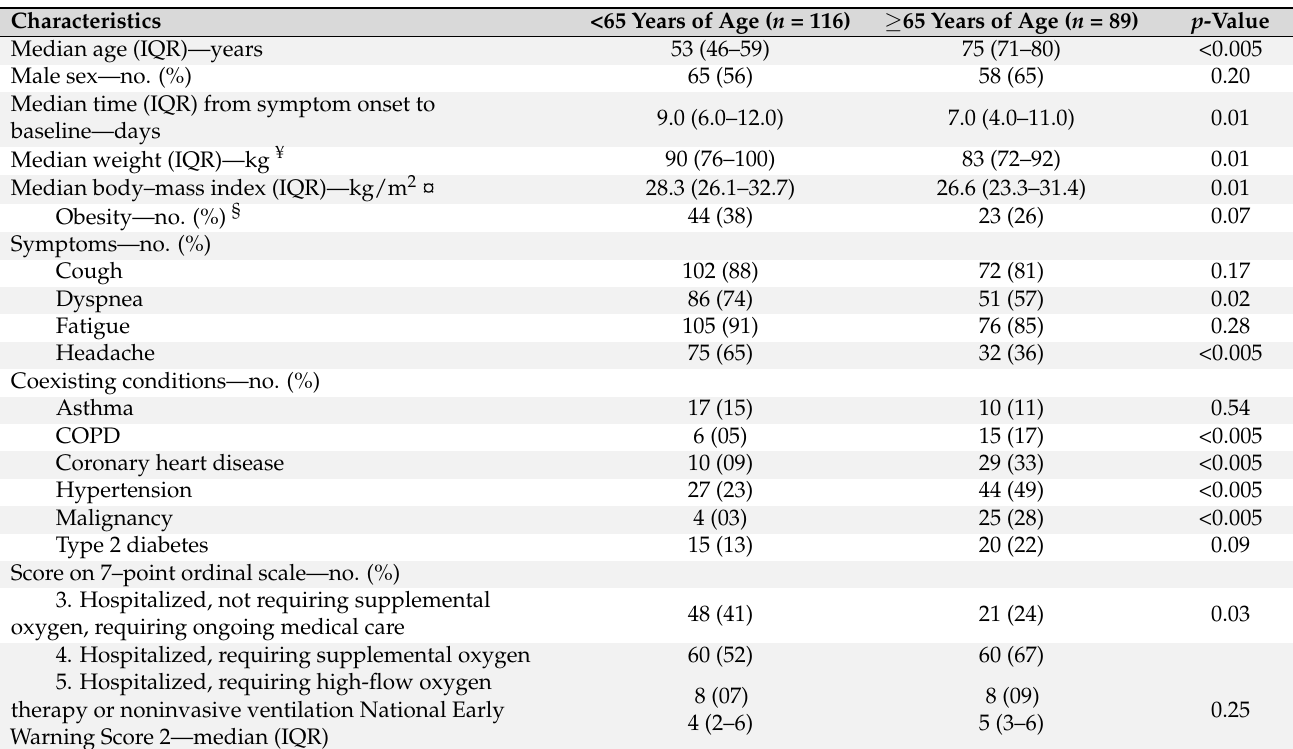
Table 1. Baseline